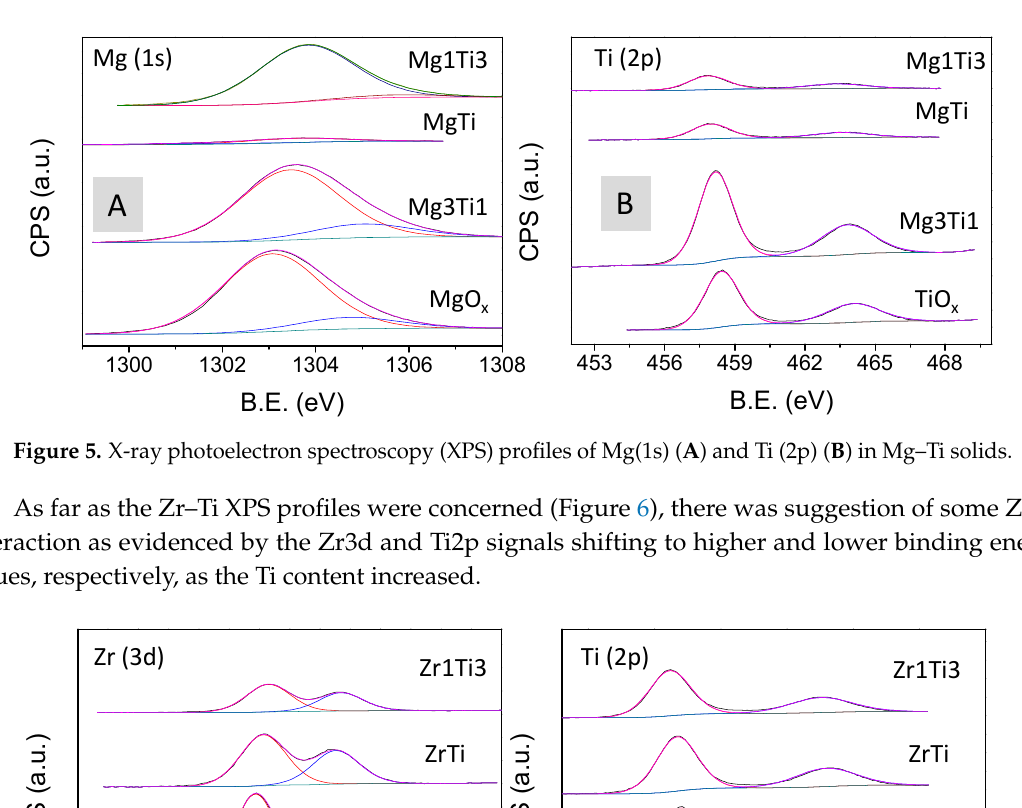
Figure 6. XPS profiles of Zr(3d) ( A ) and Ti (2p) ( B ) in Zr–Ti solids.